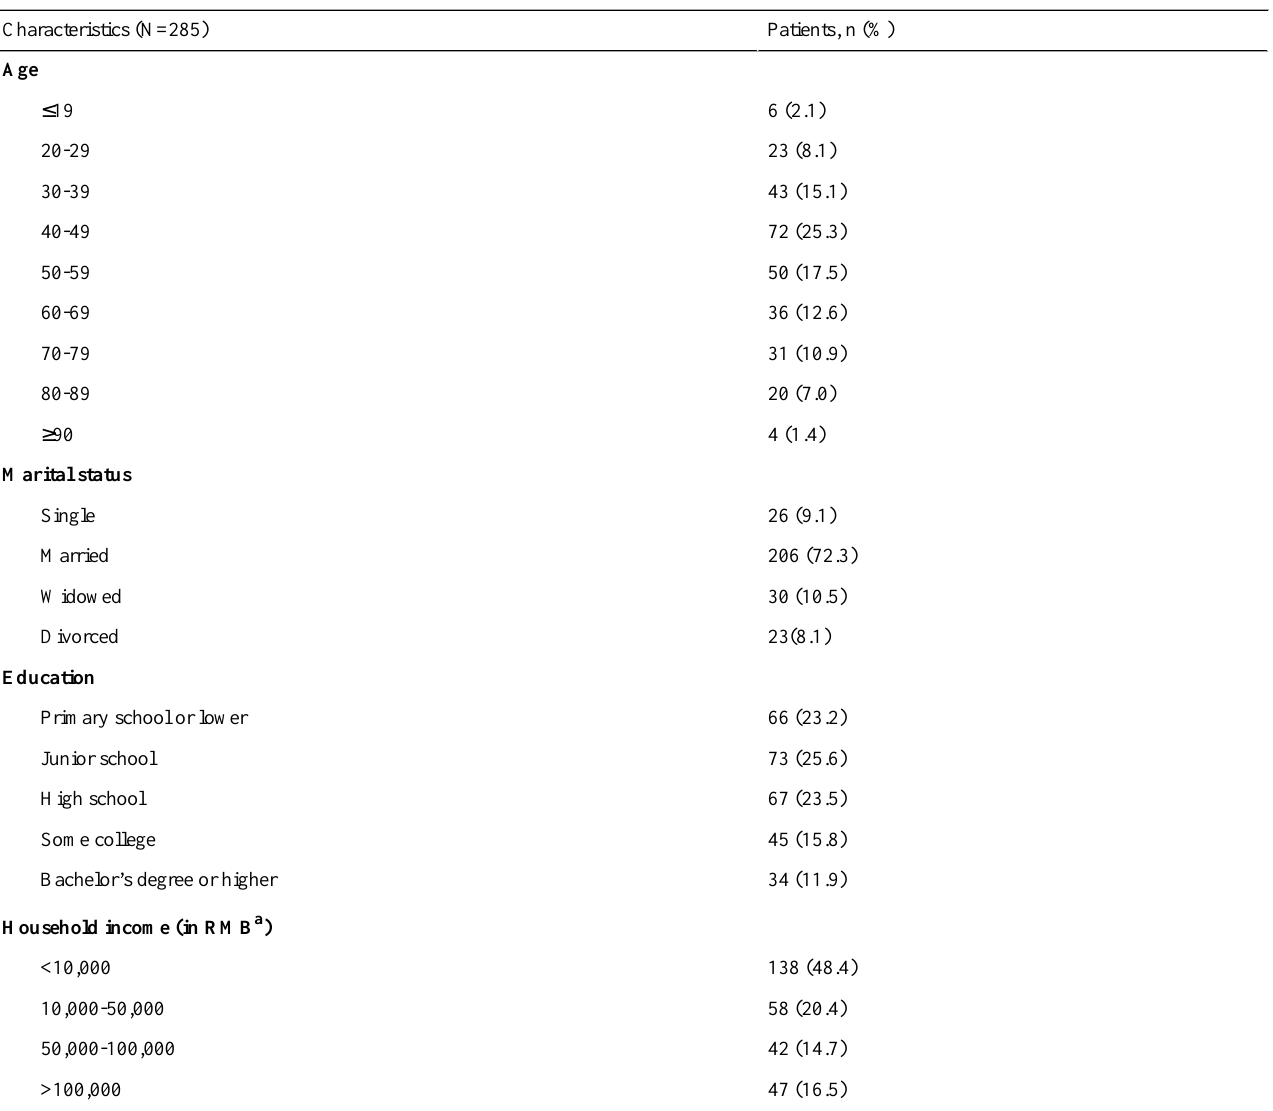
Table 1. Participant demographic